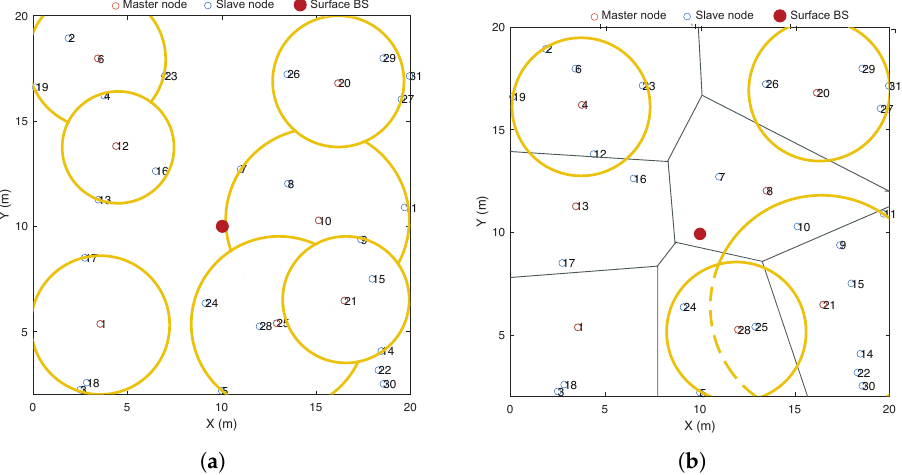
Figure 8. The examples of the two algorithms. ( a ) An example of CCMF algorithm. ( b ) An example of LEACH-C